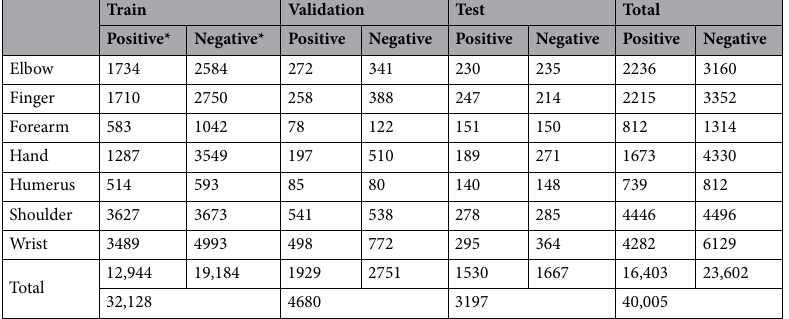
Table 1. Number of images in each anatomical category. *Positive or negative represents abnormal or normal, respectively.